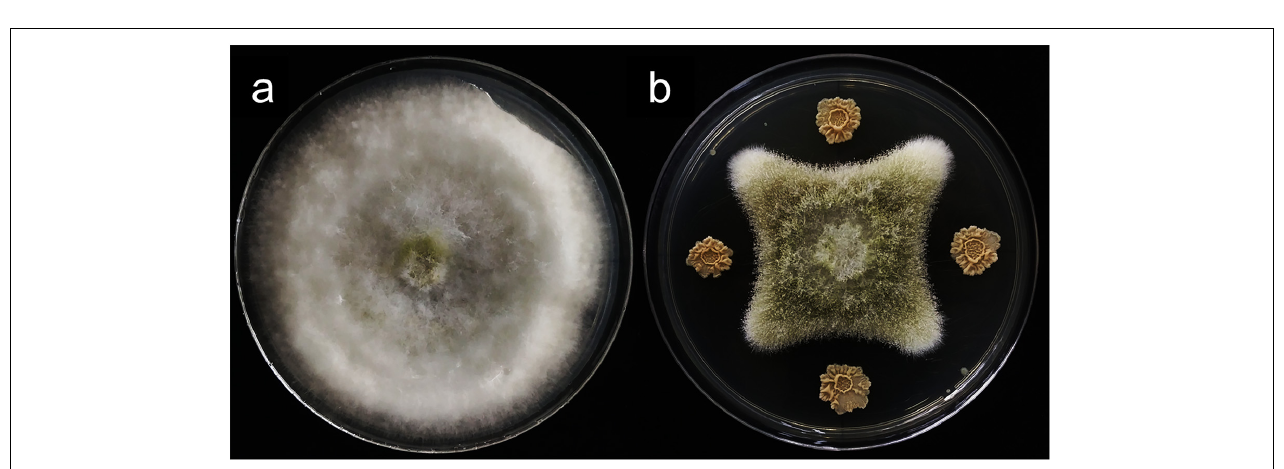
FIGURE 1 | Aflatoxin B 1 (AFB 1 ) transformation characteristics of Pseudomonas geniculata m29 ( P. geniculata m29). (A) Effect of temperature on AFB 1 transformation by P. geniculata m29. (B) Kinetics of AFB 1 transformation by P. geniculata m29 at 37 ◦ C. Values expressed as mean ± SD, and different letters represent significant difference according to Tukey’s LSD test ( p < 0.05).